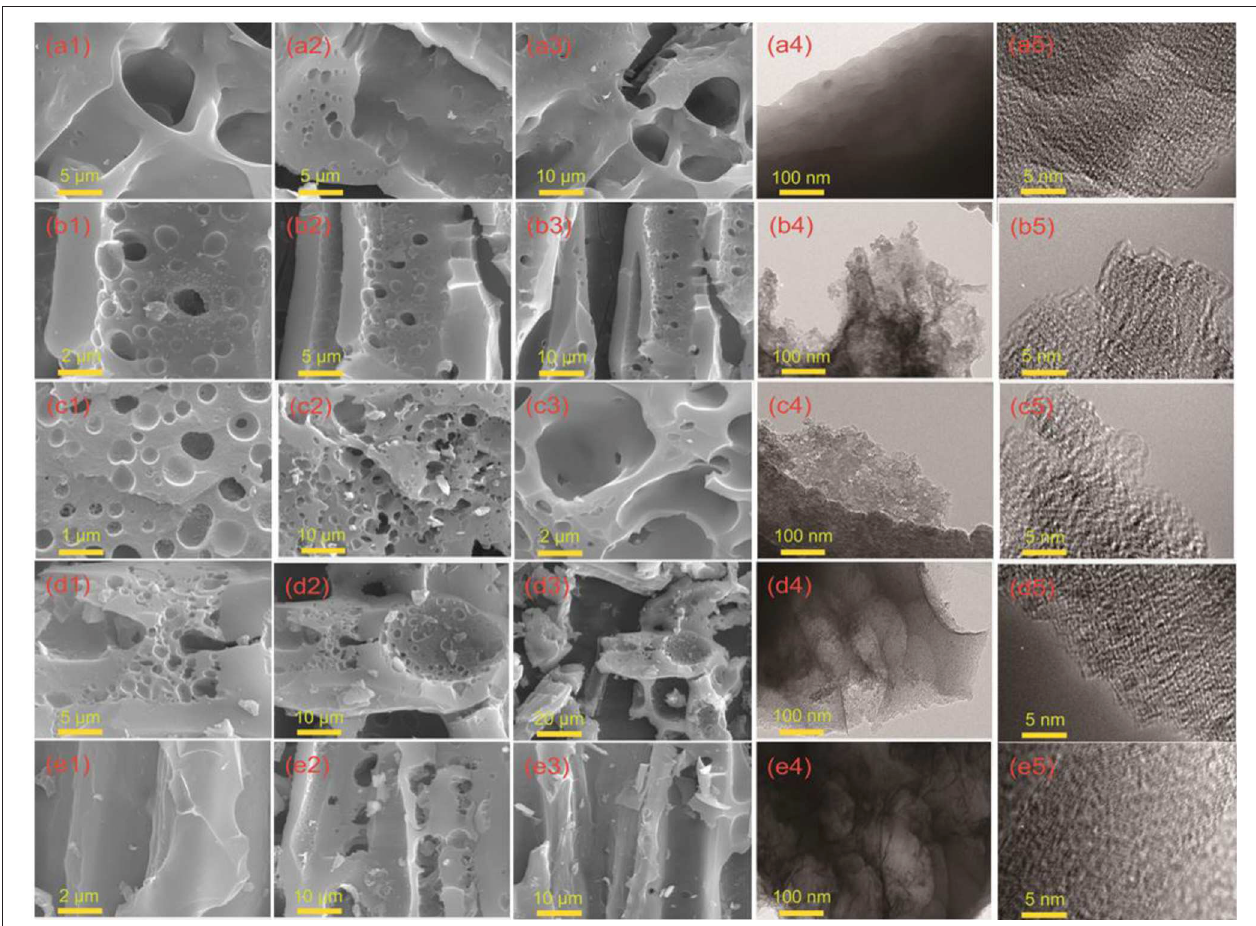
FIGURE 1 | Morphology and structure characterization of DSPCs. (a1-a3) SEM image of DSPC-600, (a4,a5) TEM and HRTEM image of DSPC-600. (b1-b3) SEM image of DSPC-700, (b4,b5) TEM and HRTEM image of DSPC-700. (c1-c3) SEM image of DSPC-800, (c4,c5) TEM and HRTEM image of DSPC-800. (d1-d3) SEM image of DSPC-900, (d4,d5) TEM and HRTEM image of DSPC-900. (e1-e3) SEM image of DSPC-1000, (e4,e5) TEM and HRTEM image of